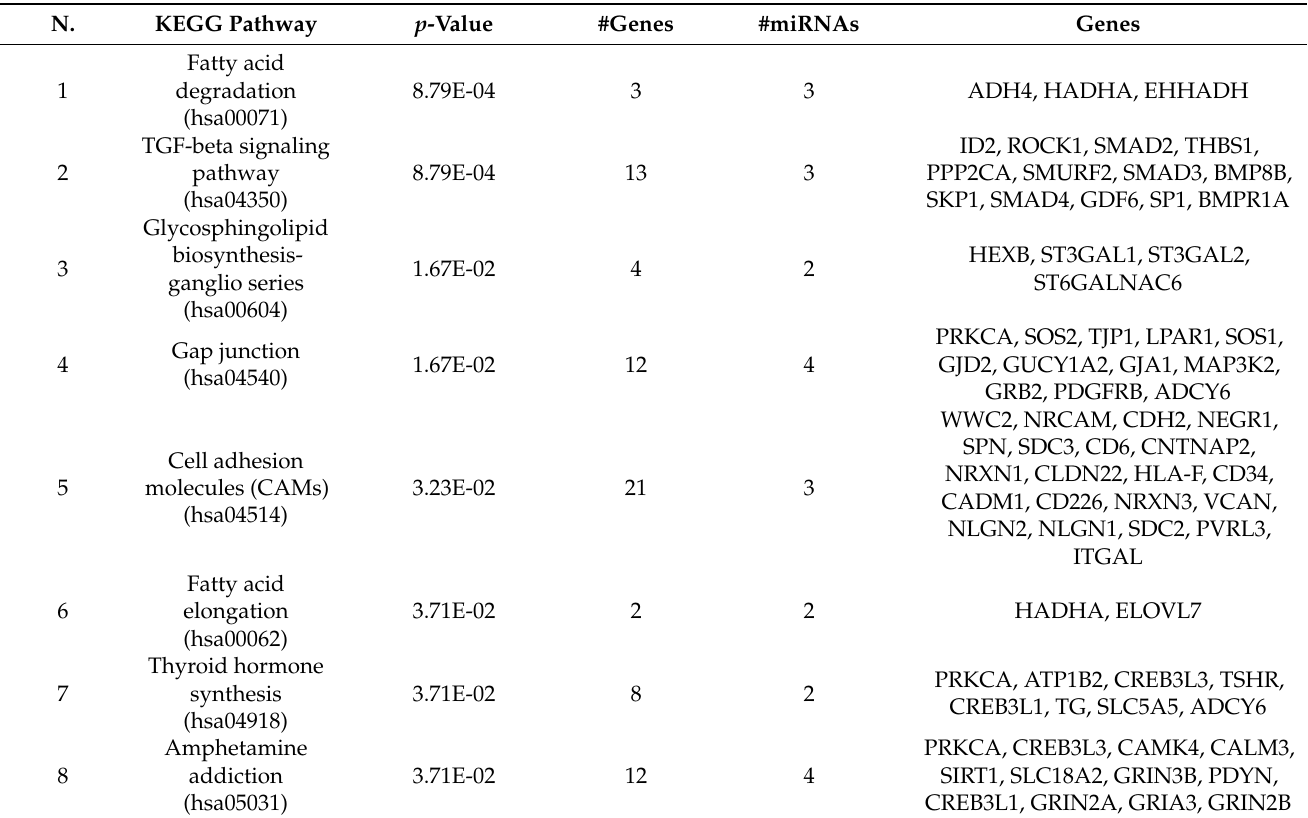
Table 3. Molecular pathways altered by the five up-regulated miRNAs after pesticide exposure.